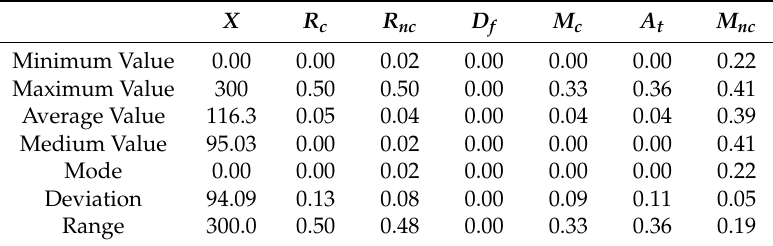
Table 3. Statistical analyses of strategies R c , R nc , D f , M c , A t , and M nc .